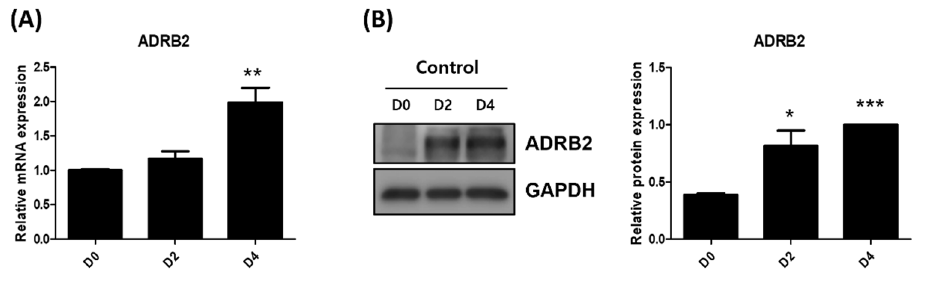
Figure 2. Differentiated HMGECs increased expression of beta 2-adrenergic receptor (ADRB2) ( A ) HMGECs were cultured with differentiation media from Day 0. mRNA ( A ) and protein expression ( B ) were measured by quantitative PCR and immunoblotting at day 0, 2, and 4, respectively. Data are presented as the mean ± standard error of the mean. D, day after differentiation; * p < 0.05; ** p < 0.01, *** p < 0.001.